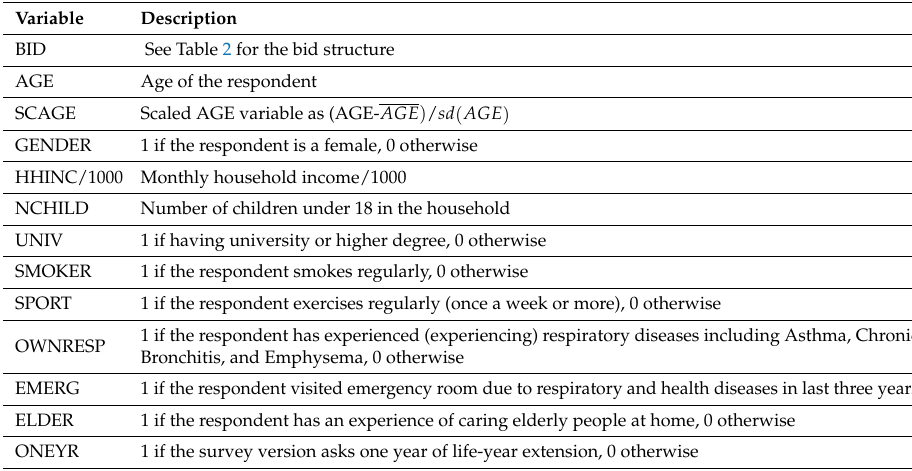
Table 1. Variable descriptions.